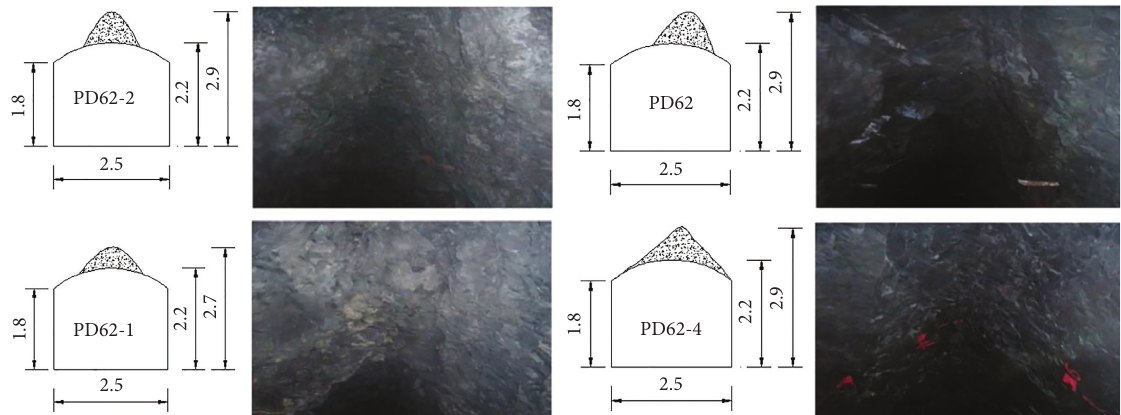
Figure 3: Spalling features of tunnels on the right